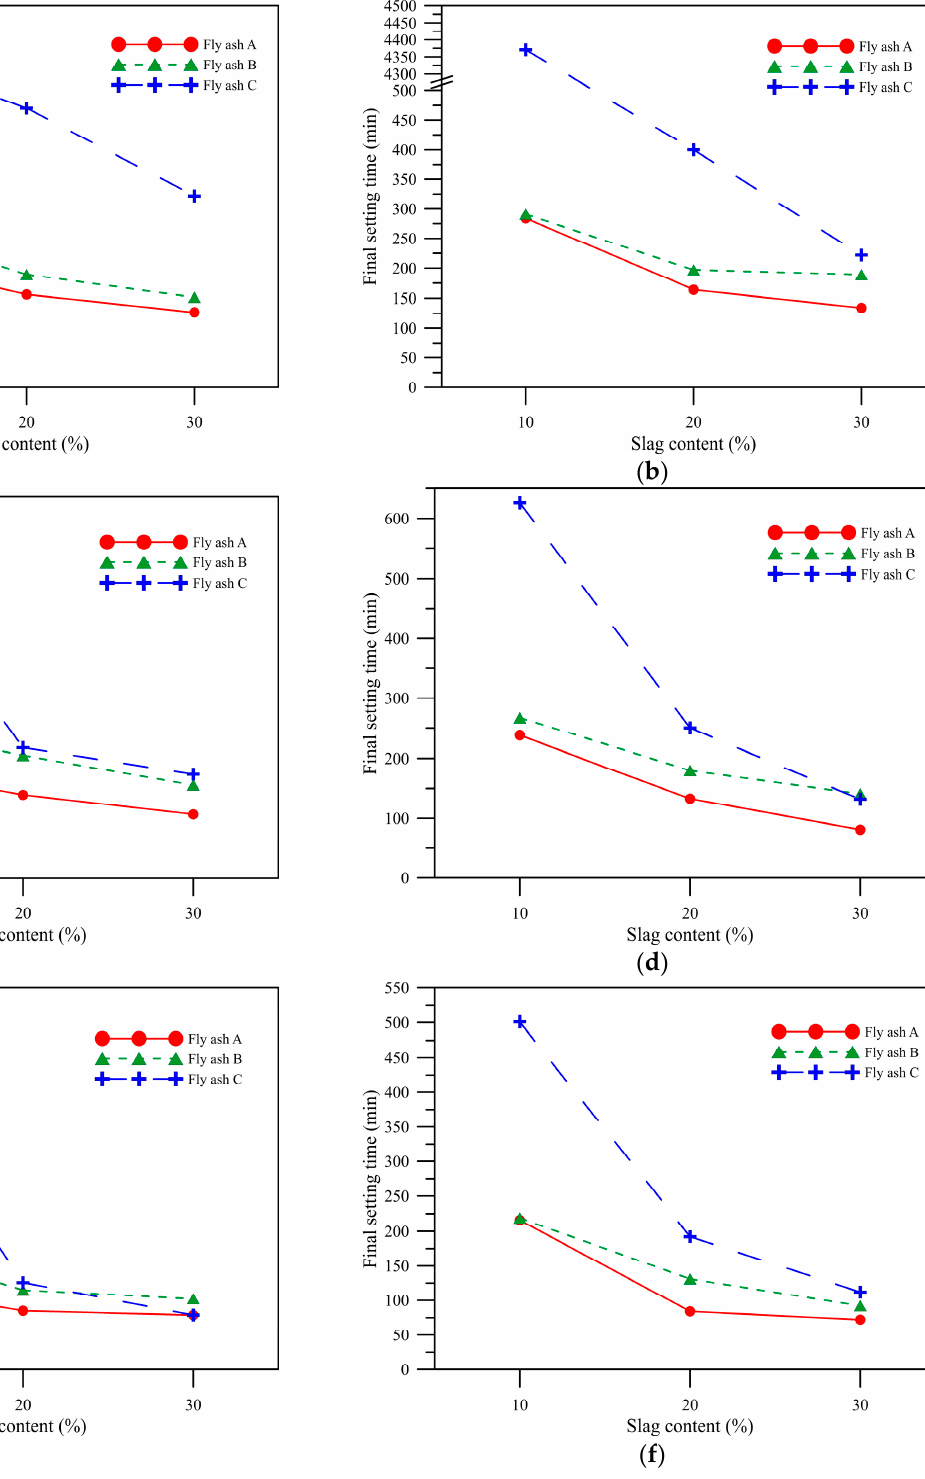
Figure 4. Initial and final setting times for different alkali equivalents and GGBFs replacements. ( a ) AE% = 3% initial setting times, ( b ) AE% = 3% final setting times, ( c ) AE% = 5% initial setting times, ( d ) AE% = 5% final setting times, ( e ) AE% = 8% initial setting times, ( f ) AE% = 8% final setting times.